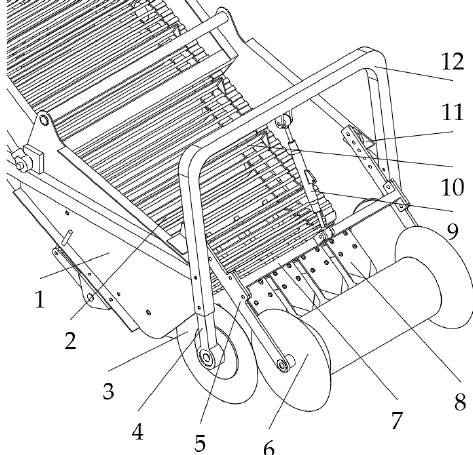
Figure 3. CAD model of the digging and lifting device of the self-propelled machine for combined potato harvesting and residual plastic fi lm retrieval: 1—side plate of the digging device; 2—lifting chain; 3—earth-cu tt ing disc; 4—disc support; 5—connecting plate; 6—pro fi ling crushing roller; 7—connecting crossbar; 8—digging shovel; 9—limiting pull rod; 10—scraper; 11—ear plate; 12—U-shaped connecting rod.